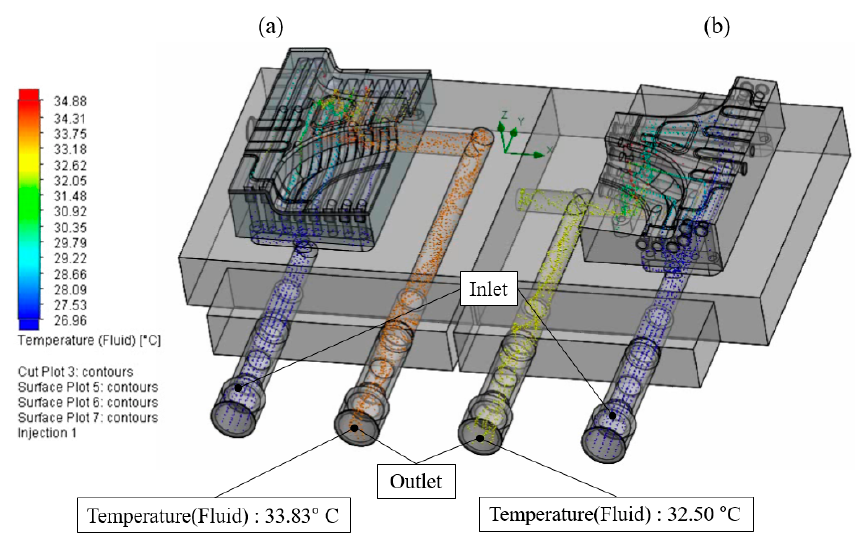
Figure 10. Temperature analysis of coolant-outlet pipe using continuous process heat flow in ( a ) conformal cooling channel; ( b ) conventional linear cooling channel.